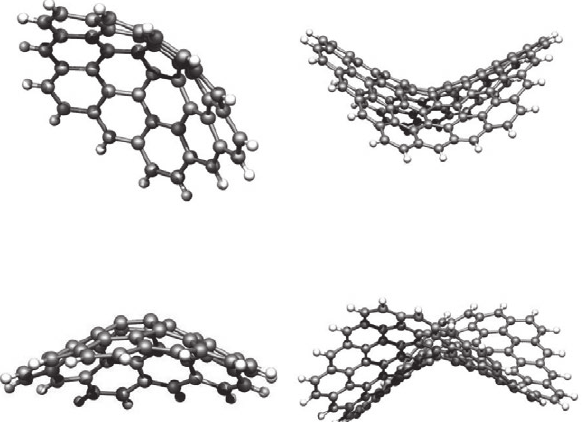
Figure 6. (Left/Right) The formation of rings less than/greater than 6-rings in a flat graphite sheet (tiled by hexagons) leads to positive/ negative disclinations. Copyright Chris Ewels (www.ewels.info).